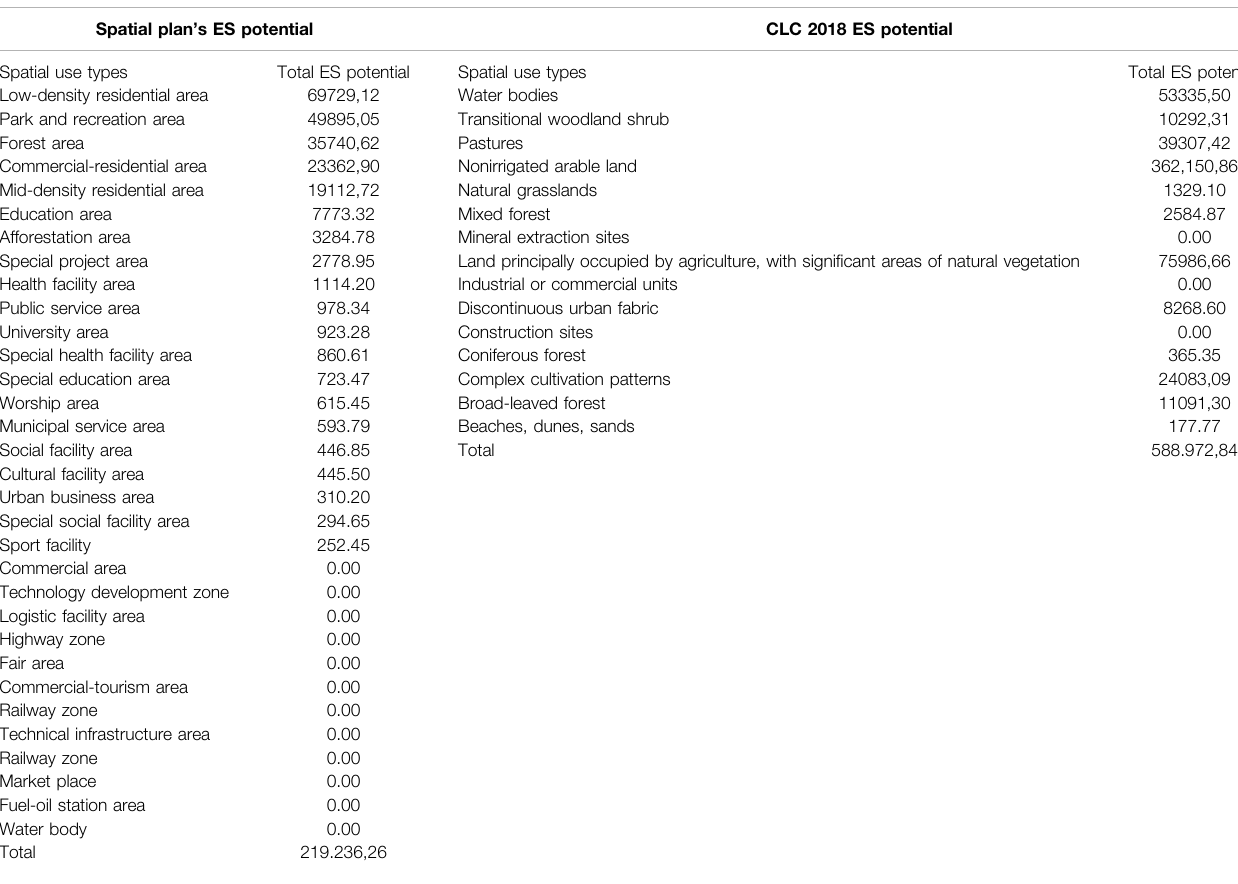
TABLE 6 | ES potential estimations of Canal Istanbul ’ s spatial plan and CLC 2018 Spatial plan ’ s ES